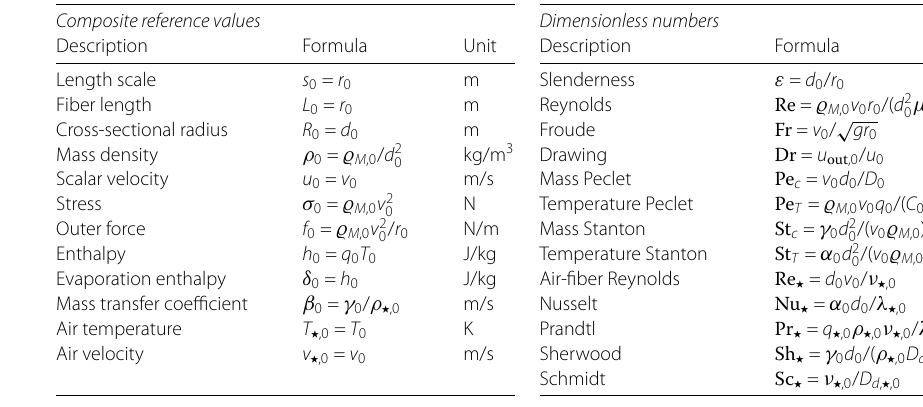
Table 1 Overview over composite reference values used for non-dimensionalization of the uni-axial fiber dry spinning model and the resulting dimensionless numbers. Here, the scales (cid:14) M ,0 , v 0 , r 0 , d 0 , μ 0 , q 0 , T 0 , α 0 , γ 0 , C 0 , D 0 , u out ,0 , ρ (cid:5) ,0 , p (cid:5) ,0 , q (cid:5) ,0 , ν (cid:5) ,0 , λ (cid:5) ,0 , D d , (cid:5) ,0 are assumed to be given from